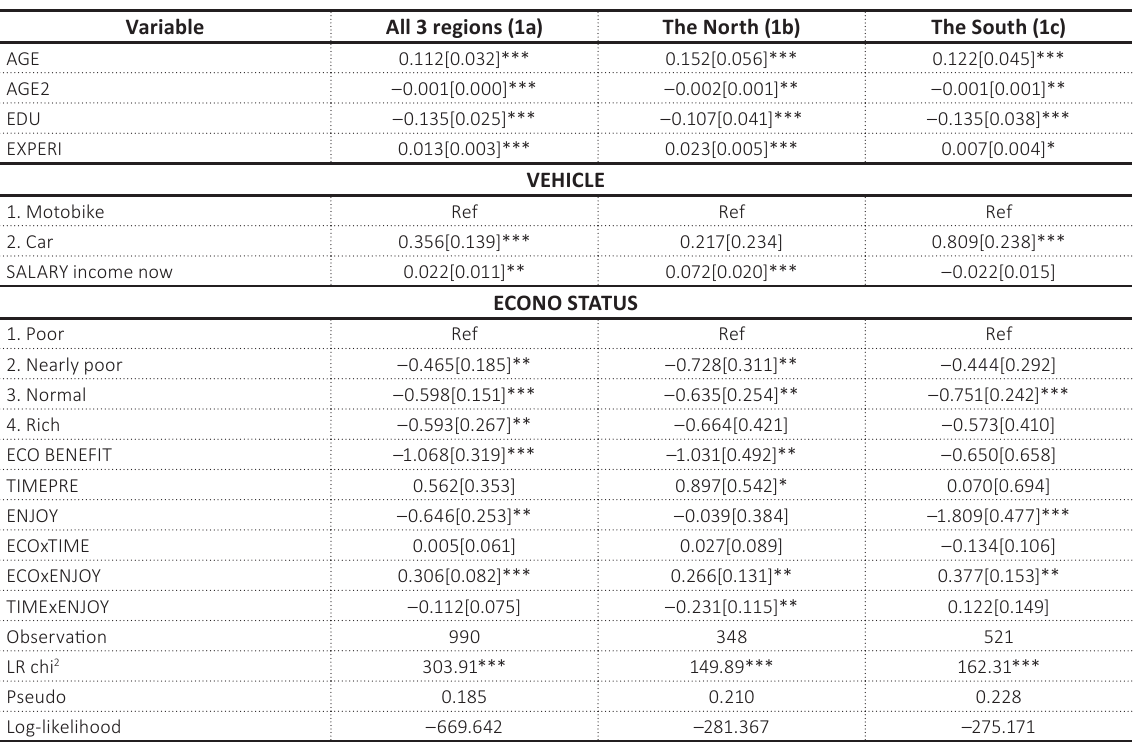
Table 4. Ordered probit estimation